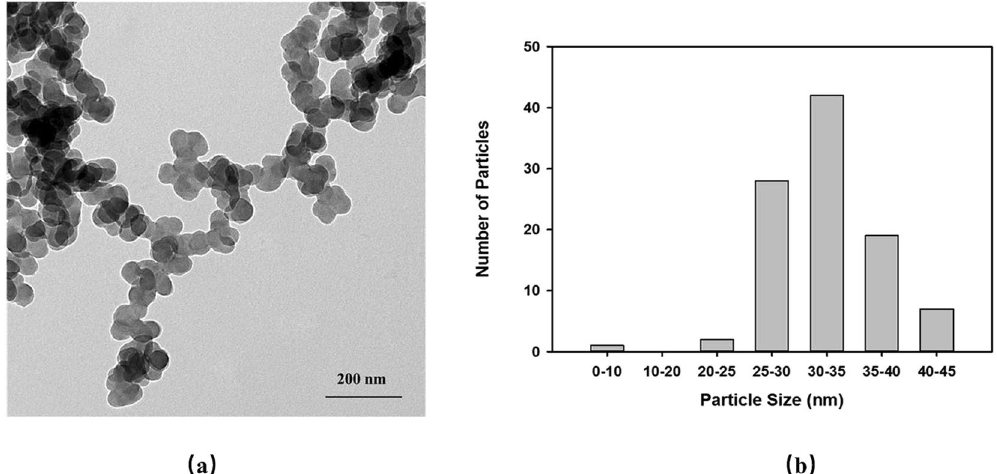
Figure 1. Transmission electron microscopy (TEM) image ( a ) and the histogram of size distribution ( b ) of CMC-stabilized FeS nanoparticles (FeS = 10 mg/L, CMC = 0.001 wt.%). The mean particle size is 32.18 ± 5.25